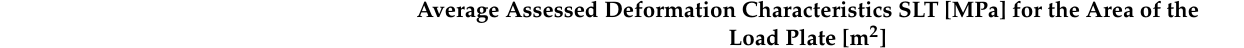
Table 3. Recapitulation of SLT results with different size of load plate.